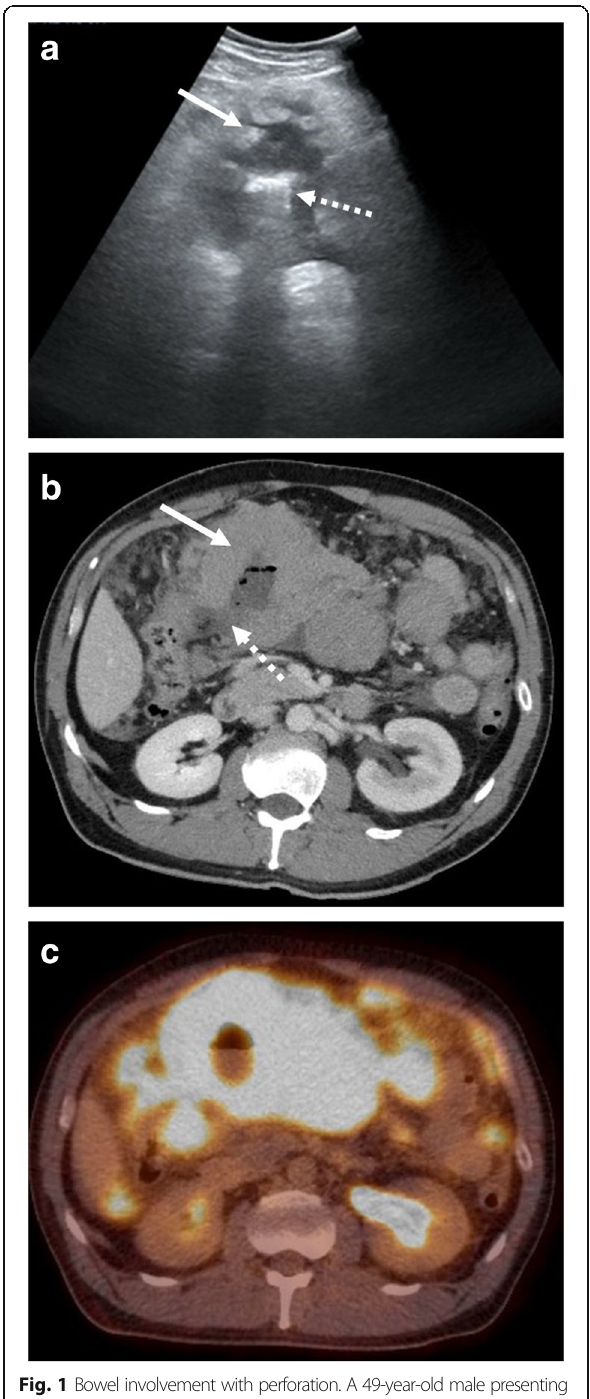
Fig. 1 Bowel involvement with perforation. A 49-year-old male presenting to the emergency department with abdominal pain. a Transverse grayscale ultrasound image demonstrates mass-like thickening of a bowel loop within the mid-abdomen (solid arrow) with central air and associated dirty shadowing (dashed arrow). b Subsequently performed axial CT shows a large central mass (solid arrow) with associated perforation (dashed arrow). c Follow-up fused axial PET-CT demonstrates associated hypermetabolic activity and extensive background abdominal disease. Burkitt lymphoma was confirmed at